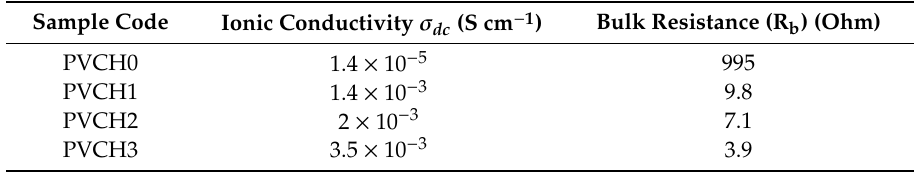
Figure 3. Impedance plot ( Z i versus Z r ) of the PVA: CS: 40%NH 4 SCN incorporated with ( a ) 0% glycerol, ( b ) 14% glycerol, ( c ) 28% glycerol, and ( d ) 42% glycerol. Table 2. The ionic conductivity σ dc of un-plasticized and plasticized of PVA: CS: NH 4 SCN systems at ambient temperature.